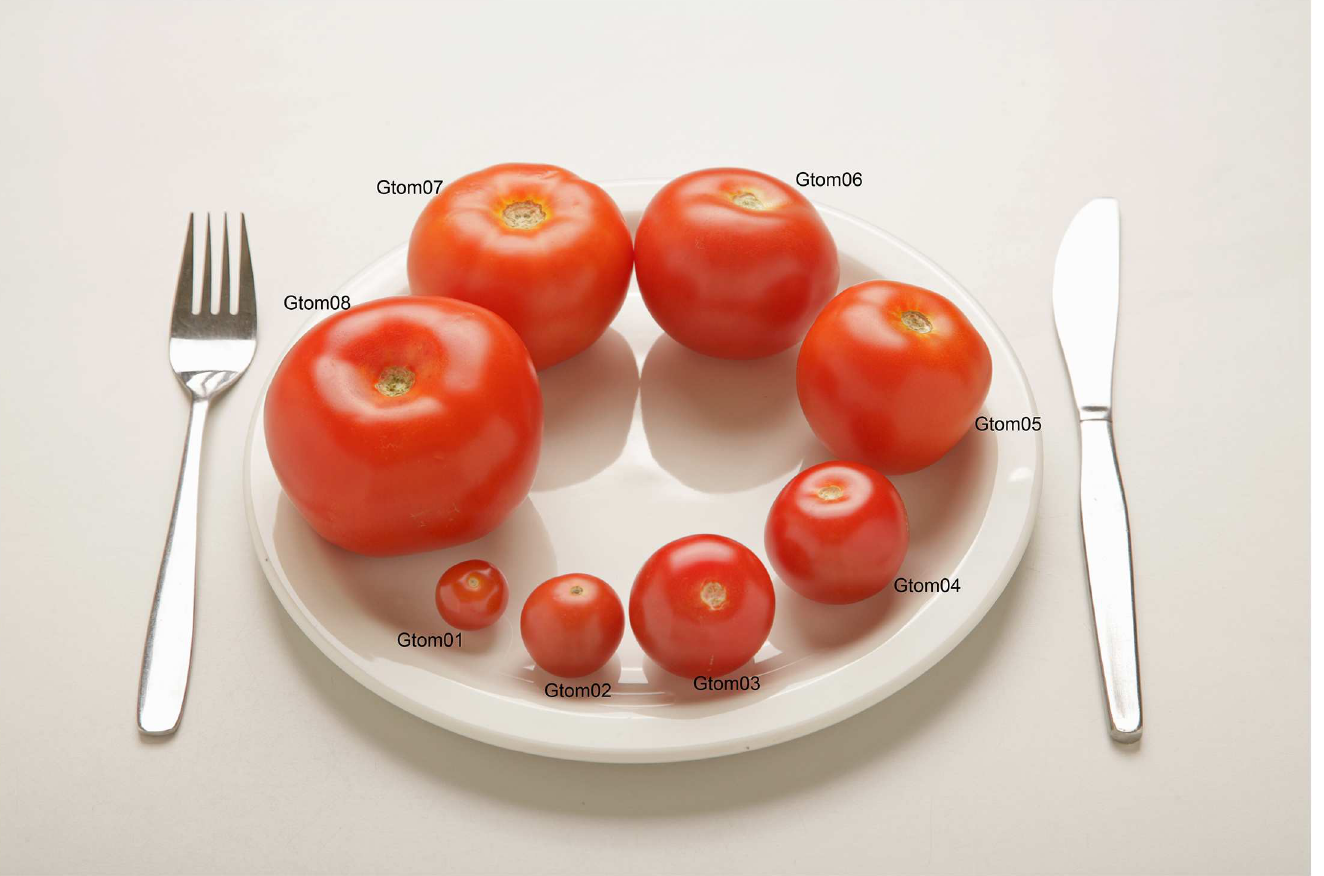
Fig 2. Example page from food atlas—guide